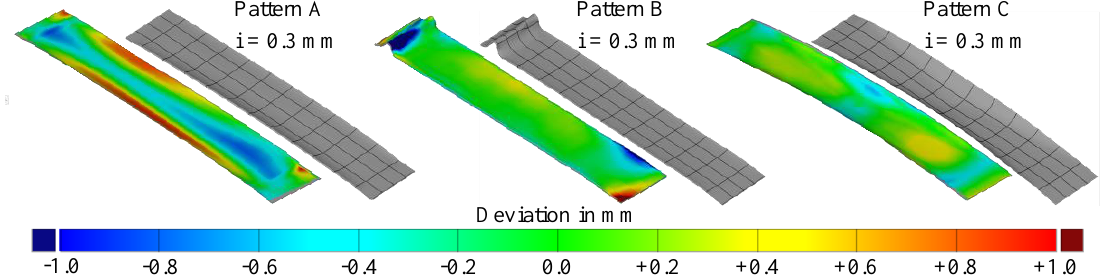
Figure 10. Comparison of FE modeled results and experiments for different tool path patterns (color plots). The grey plots with the projected lines should provide a better visibility of the curvatures.